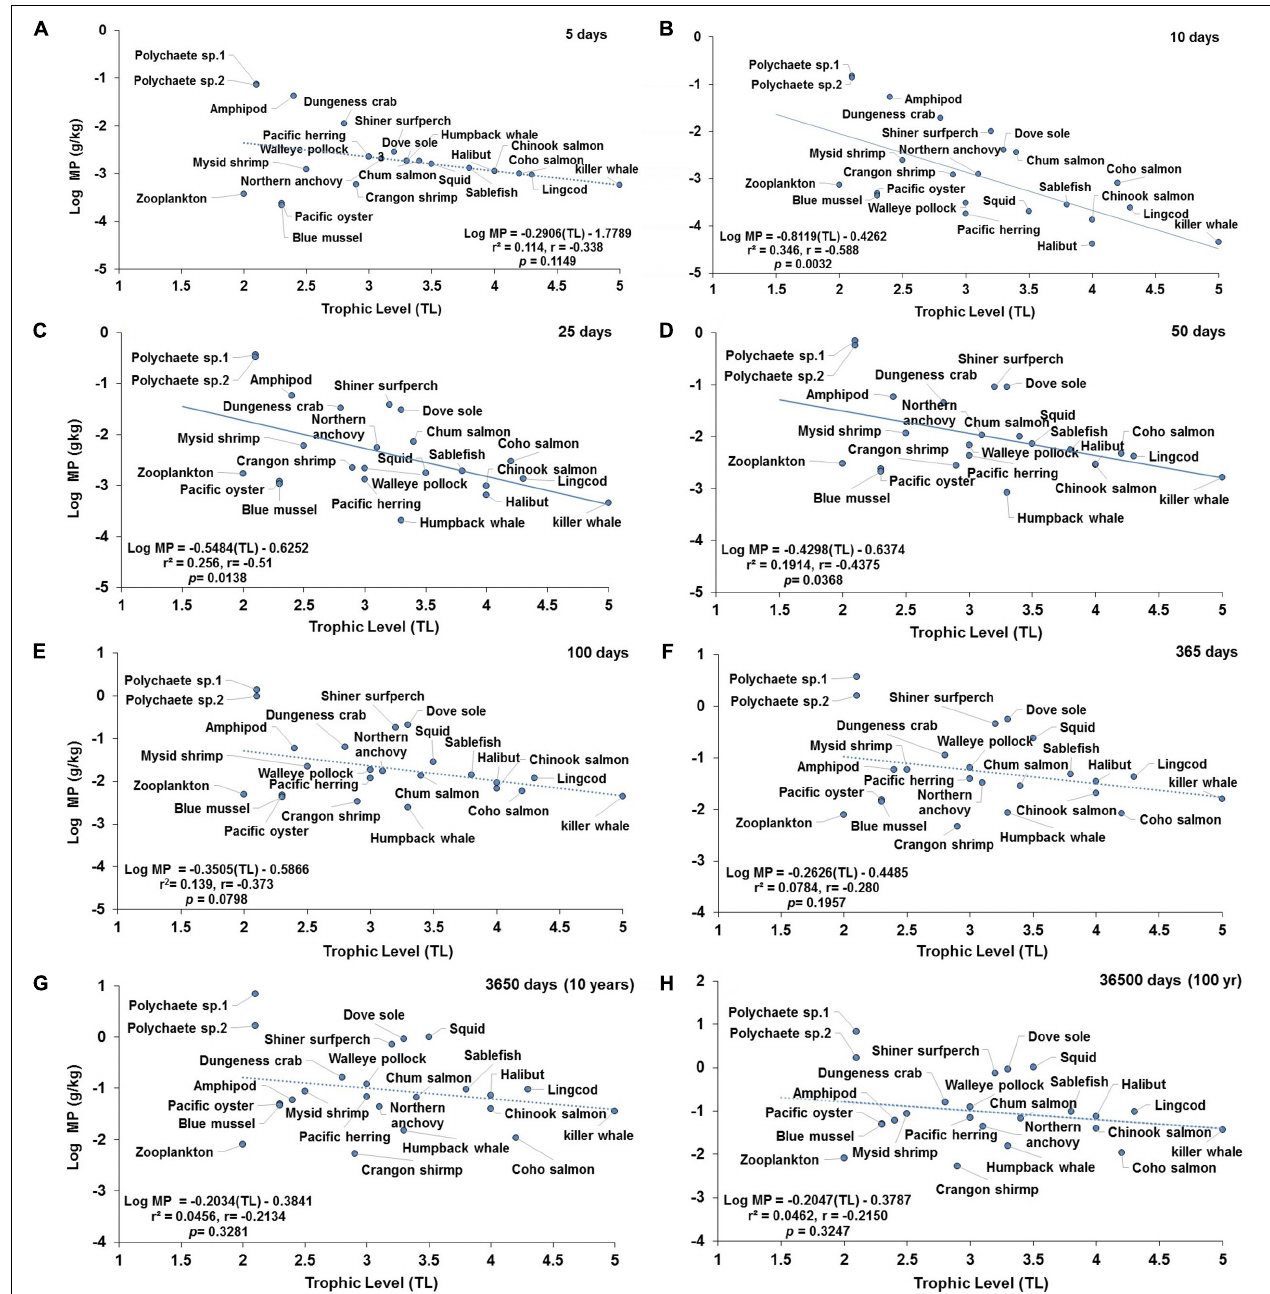
FIGURE 4 | Projections of the apparent trophic magnification factor (TMF) as a function of predicted concentration of microplastics (MPs) versus trophic level (TL) in the cetaceans’ food web of the Northeastern Pacific for simulations under a scenario of low abiotic concentrations (scenario 1: seawater = [0.003 particles/L]; and sediment = [0.266 g/kg dw] at: (A) 5 days (lack of significant relationship); (B) 10 days (regression line indicates a strong negative, significant relationship); (C) 25 days (regression line indicates a moderate and negative, significant relationship); (D) 50 days (regression line indicates a weak and negative, significant relationship); (E) 100 days (lack of significant relationship); (F) 365 days or 1 year (lack of significant relationship); (G) 3650 days or 10 year (lack of significant relationship); and (H) 36500 days or 100 year (the dotted line indicates the slope direction and a negative positive trend, but lack of a significant relationship). For zooplankton, as the key trophic level for the initial uptake of MPs, a k E = 0.143/d (i.e., retention time = 7 days) was used.